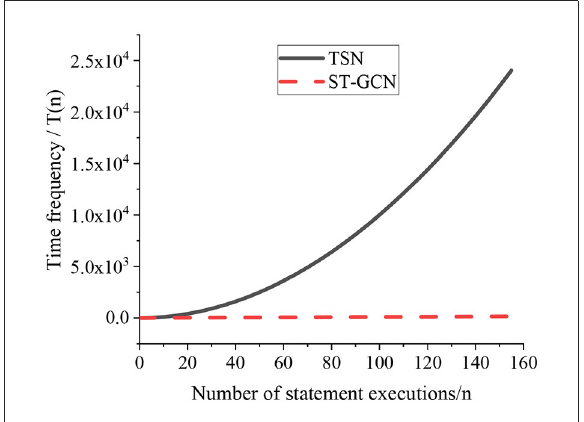
FIGURE9 Time frequency comparison of different